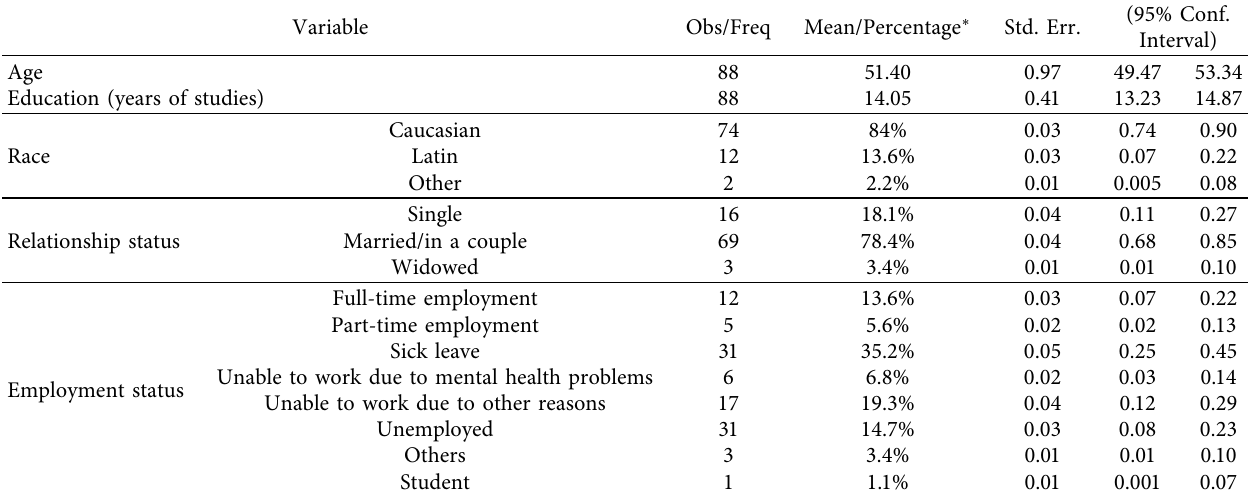
Table 1: Sociodemographic characteristics of the sample. Data are presented as the mean (SD) or number (%). Variable Obs/Freq Mean/Percentage ∗ Std.